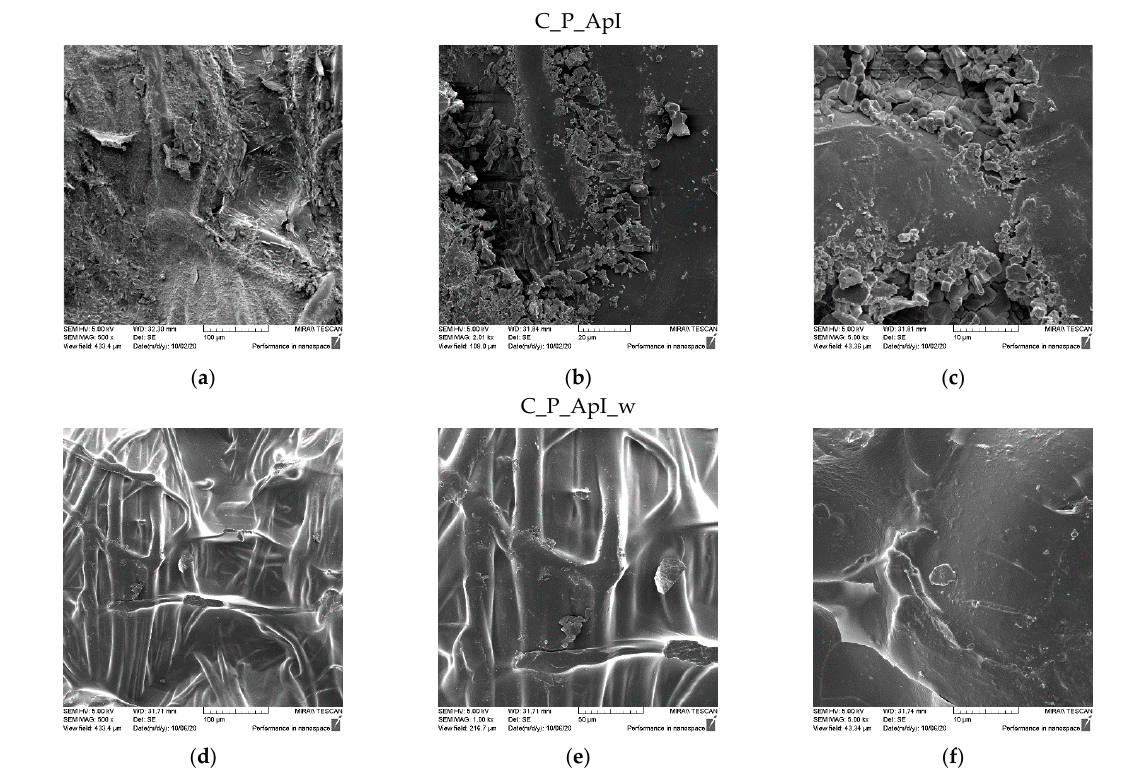
Figure 3. SEM micrographs of plain weave fabric samples treated with Bath I before (C_P_ApI) and